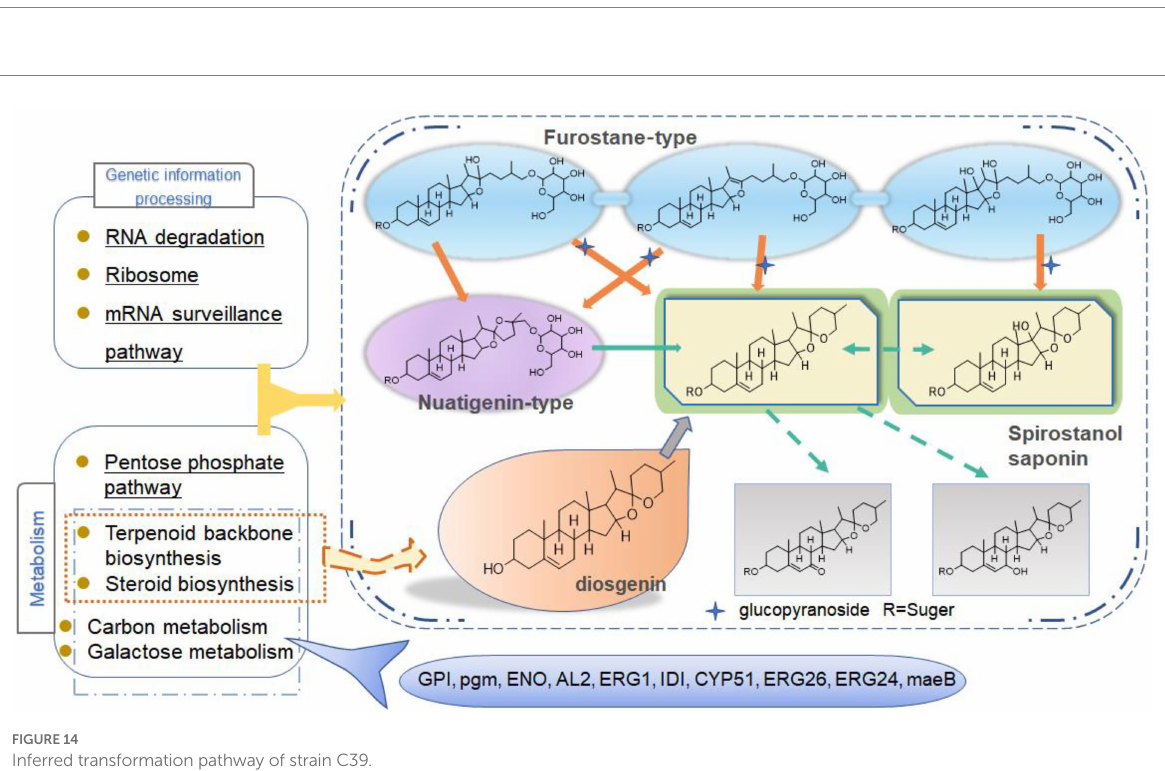
strong thermal stability and can realize the hydrolysis of 3-O-glucopyranoside of various diosgenin-type saponins (Lei et al., 2012). Through transcriptome analysis, seven glycosyltransferases, 11 glycosidases and one oxidoreductase with unknown function were screened that may promote the synthesis